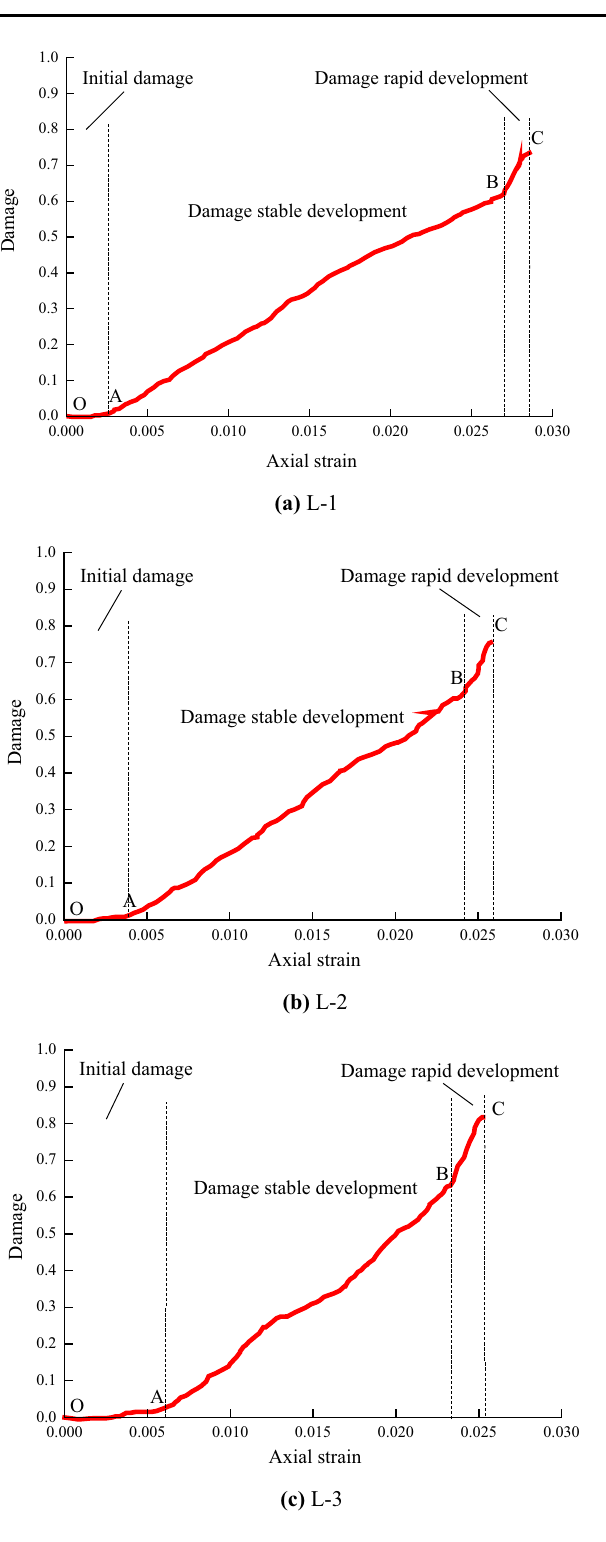
Fig. 13 The damage-strain curves